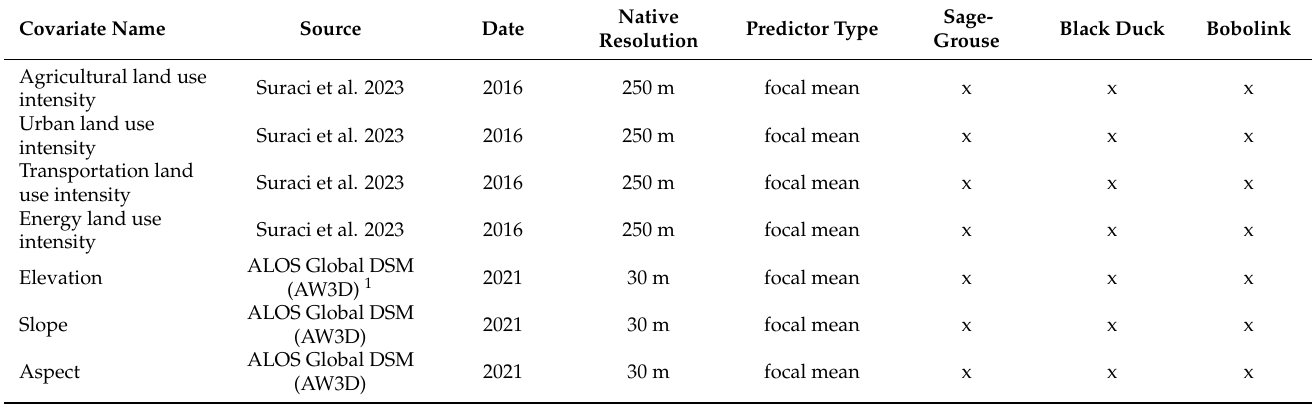
Table 1. Descriptions of the spatial covariates used in random forest models for each focal